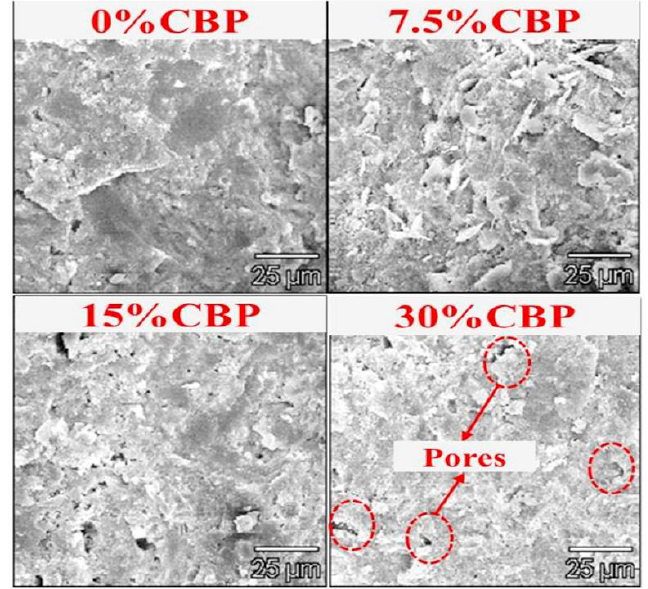
Figure 6 . SEM images with various CBP content. Reprinted/adapted with permission from Ref. [22]. 2020, Elsevier Science &Technology Journals.